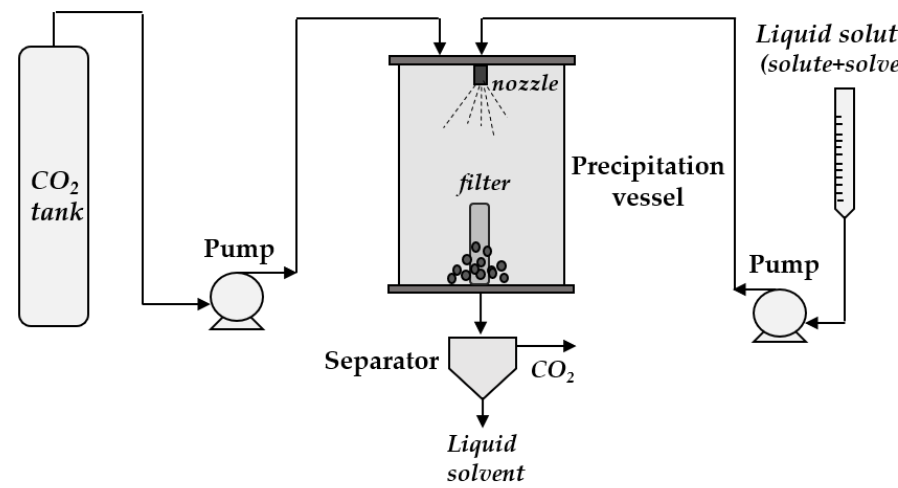
Figure 4. A sketch of the supercritical antisolvent precipitation (SAS) process.